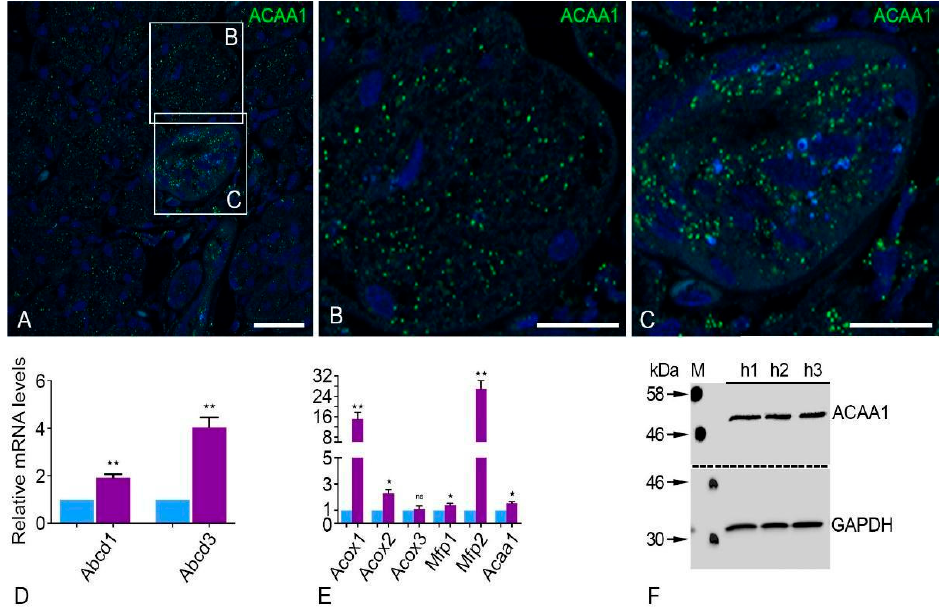
Figure 3. mRNAs encoding for proteins localized to peroxisomes and the corresponding proteins involved in the pathway for oxidizing and transporting lipids. Employing antibodies against and visualization with fluorescent secondary antibodies demonstrated high abundance of peroxisomes in the human parotid glands ( A – F ). IF staining showed peroxisomal ß-oxidation enzyme 3-oxo-acyl-CoA thiolase was abundant in the human parotid gland ( A ) and corresponding higher magnification of human acini ( B ) and striated ducts ( C ). Bars represent: 100 µm ( A ); 50 µm ( B , C ). qRT-PCR analyses for mRNAs encoding peroxisomal lipid transporters and enzymes involved in the peroxisomal ß-oxidation pathways (violet bars) were highly expressed in human parotid glands compared to Gapdh (blue bars) ( D , E ). qRT-PCR analyses on human parotid tissues showing mRNA levels encoding for β -oxidation enzymes compared to Gapdh as a housekeeping gene had the following p -values: Abcd1 ** p < 0.0034, Abcd3 ** p < 0.0020, Acox1 ** p < 0.0050, Acox2 * p < 0.0113, Mfp1 * p < 0.0265,